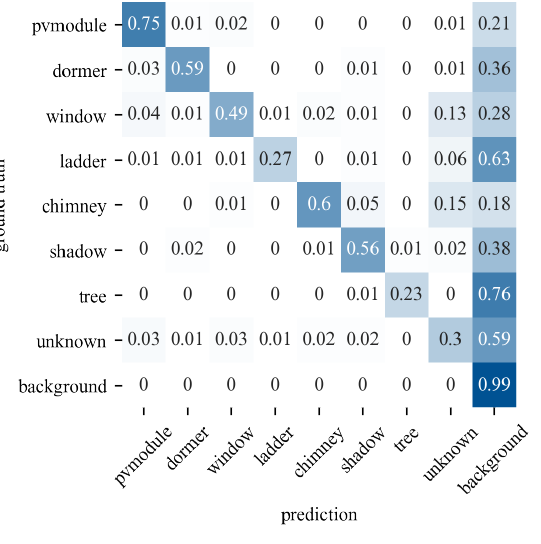
Figure 2. Confusion matrix for the RSS detection CNN . the z-axis. For chimneys, this extrusion lasts until all points of the chimney’s top polygon are at least 1 m above the roof sur- face. Dormers are extruded until all points of the top polygon are level with the highest point of the base